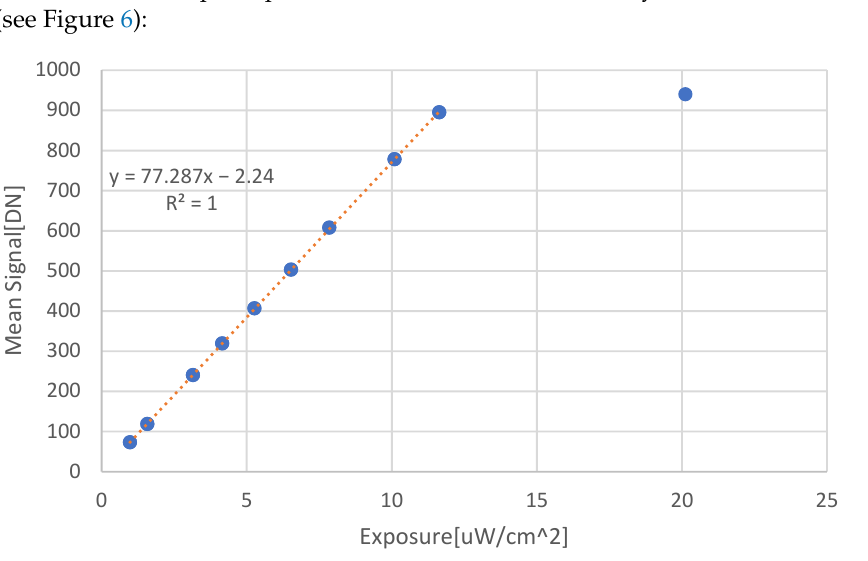
Figure 6. Measured data from which the responsivity of the sensor is extracted in units of [A/Watt], at 550 nm.